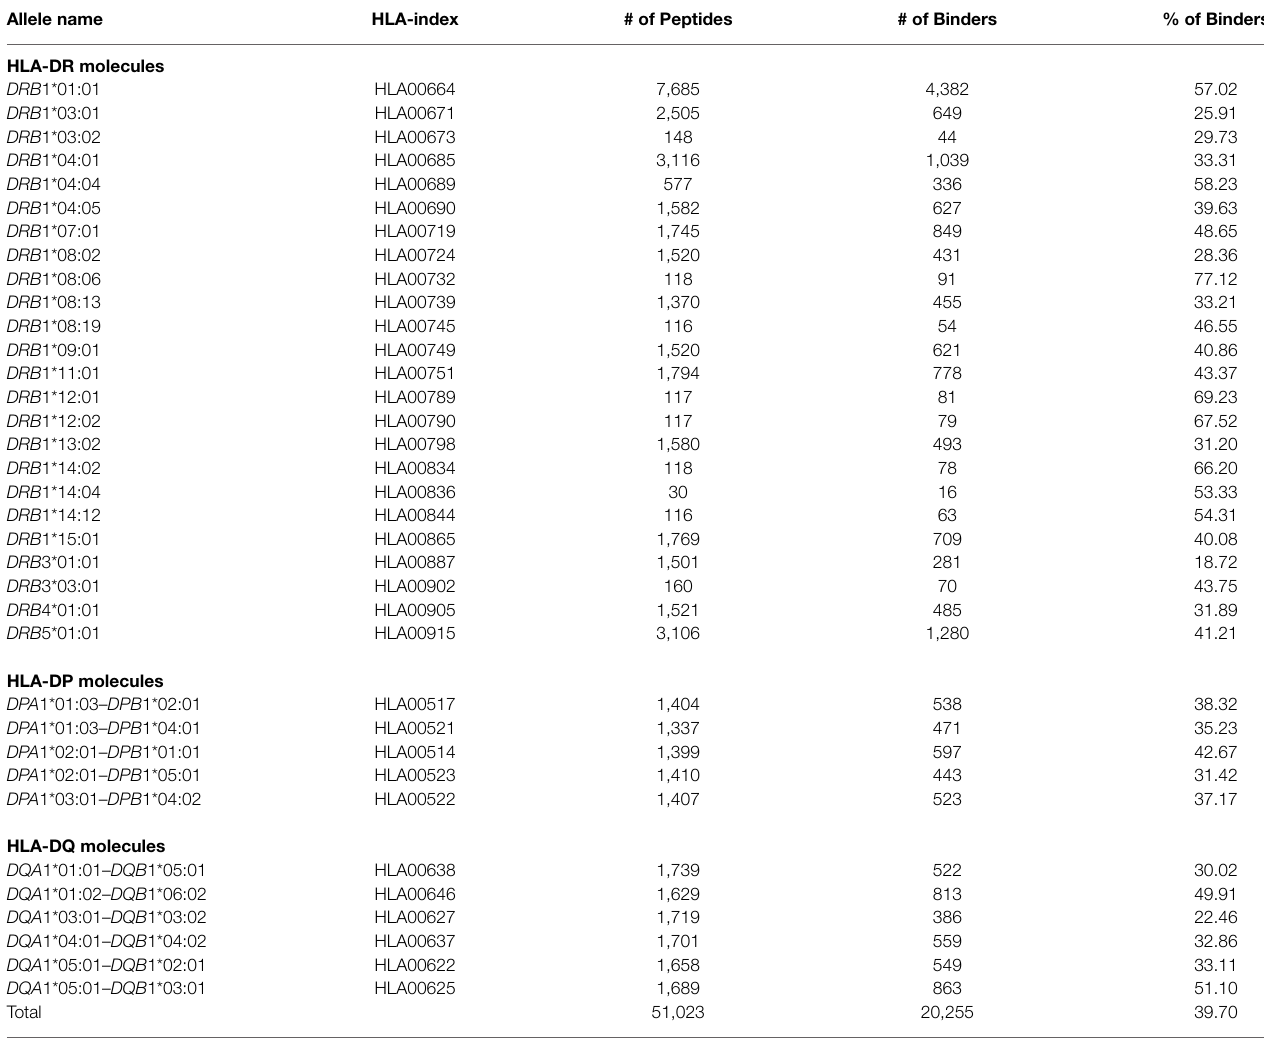
TABLE 1 | Overview of the MHC-II peptide-binding data utilized in this study. Allele